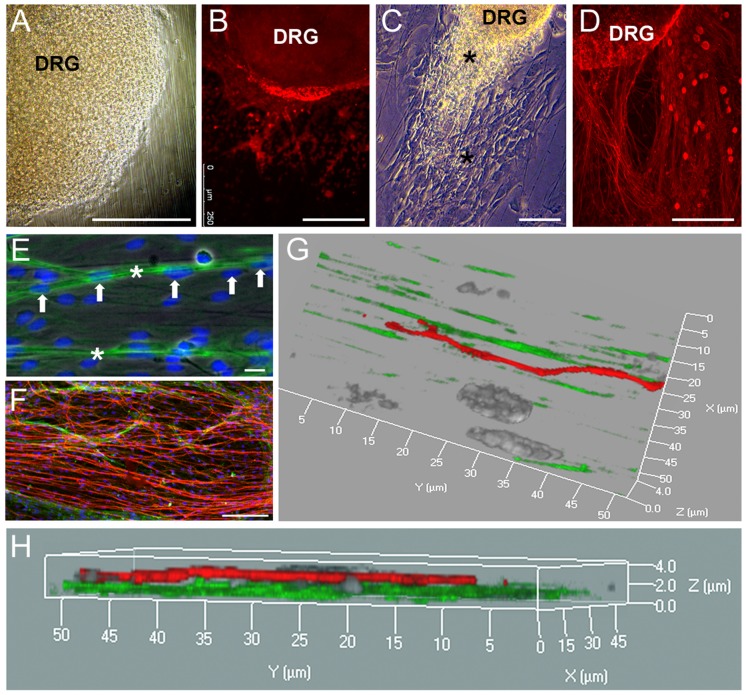
Bioactivity of multifunctionalized nanofibers in organotypic DRG culture.Fœtal DRG were seeded on unfunctionalized (A, B) or multifunctionalized (C–H) nanofibers. Images were acquired after 12 days (A, C) and 4 weeks (B, D–H) of culture. Fluorescence (B, D, E, F) and scanning laser confocal microscopy (G, H) images were obtained as described in material and methods. DRG neural tubulin was stained with anti-BIII tubulin (red), glial cells actin was stained with phalloidin (green) and nuclei with DAPI (blue). Scale bars: A, B, C, D: 250 µm; E: 10µm and G: 50µm.